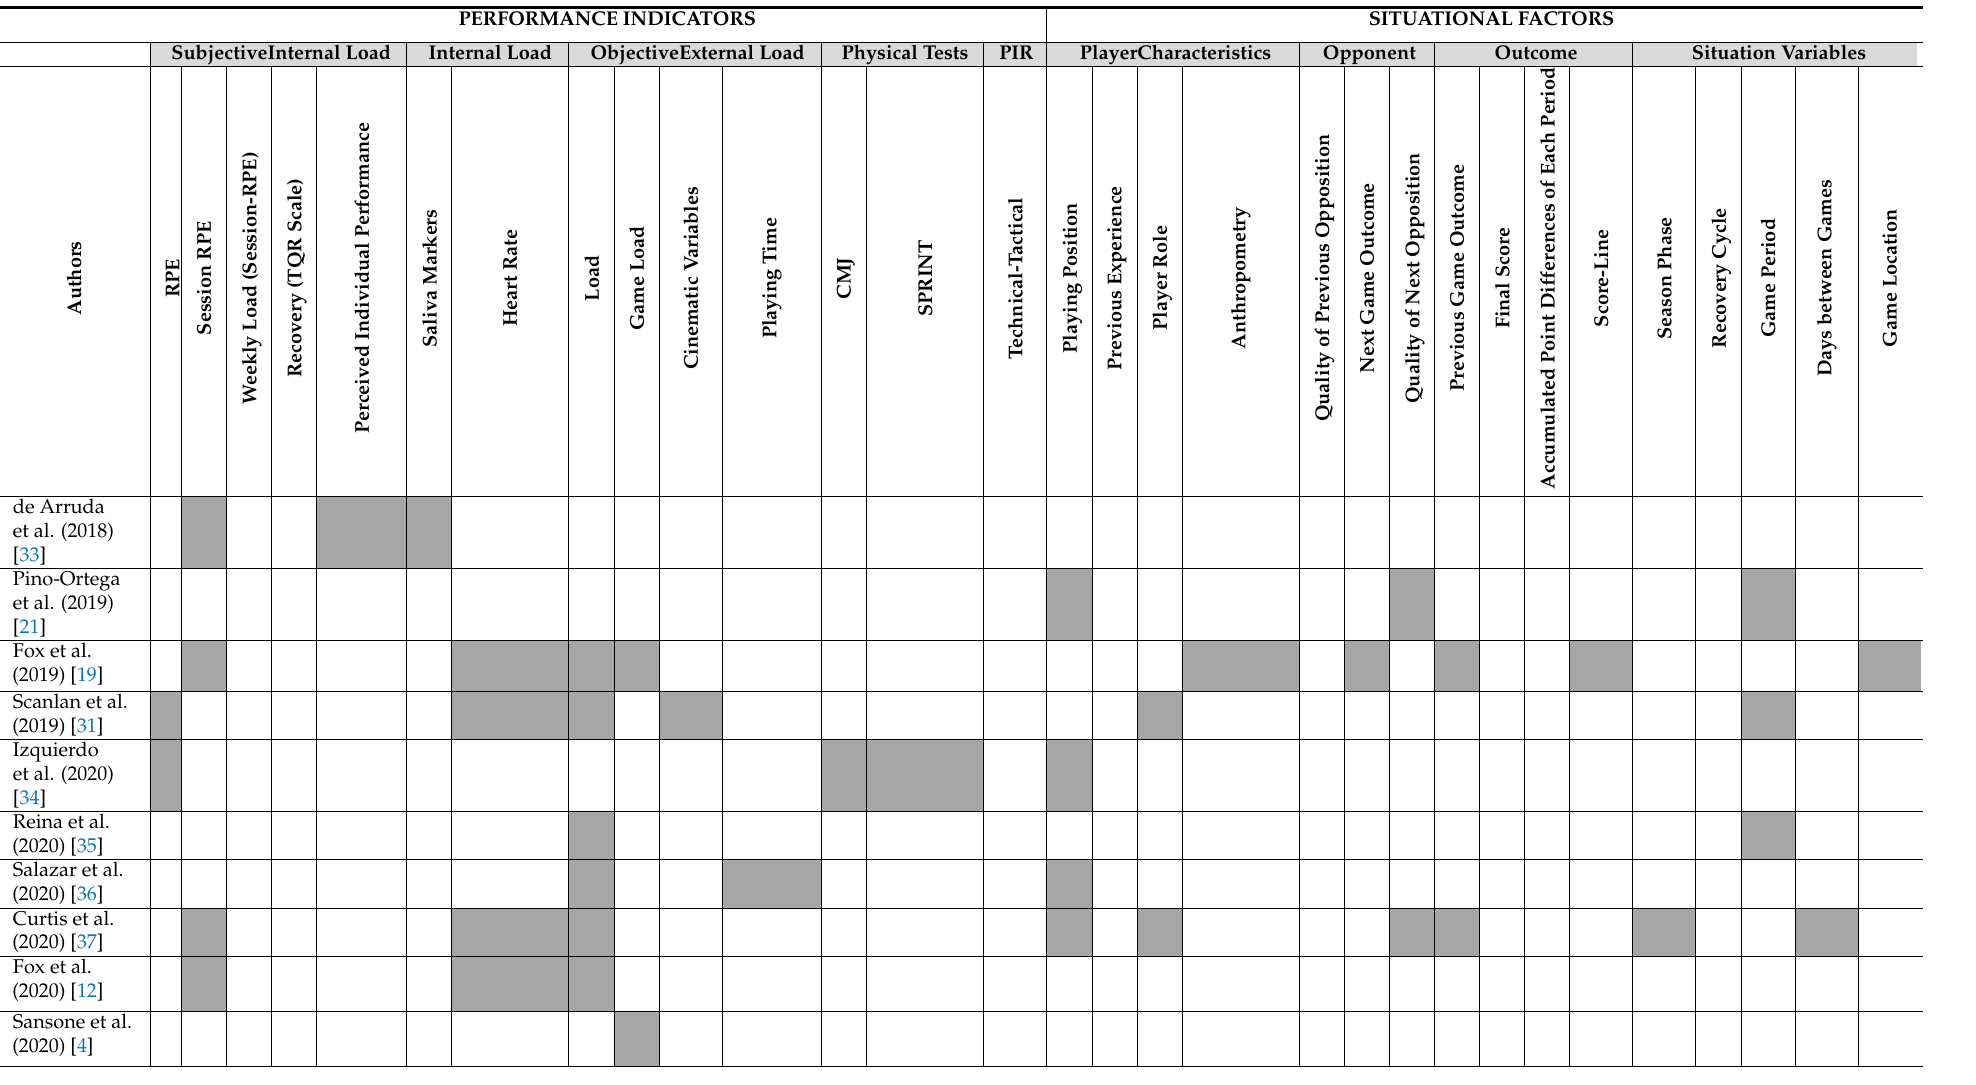
Table 1. Summary of studies relating performance indicators to situational